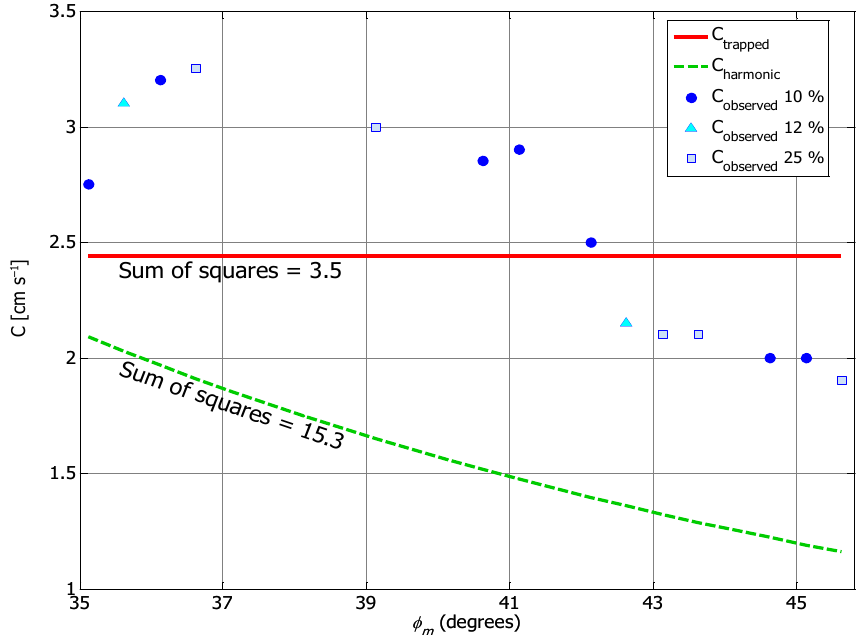
Figure 5. The observed phase speeds and the two theoretical phase speeds (trapped and harmonic) as a function of φ m in intervals of 0.5 ◦ latitude. Blue dots denote latitudes where the estimates of at least two methods agreed by 10% or less, triangles denote latitudes where such estimates agreed by 11 to 12% and squares denote latitudes where the agreement is 25%. No reliable estimates were obtained north of 35 ◦ S and in some more latitudes. The sum of squares of the distances in (cms − 1 ) 2 between trapped wave phase speeds and observed speeds (3.5) is much smaller than that of harmonic phase speeds